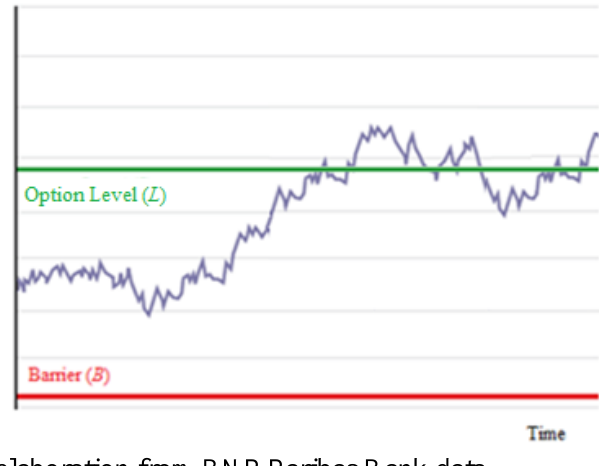
Figure 2. Underlying asset above option level.